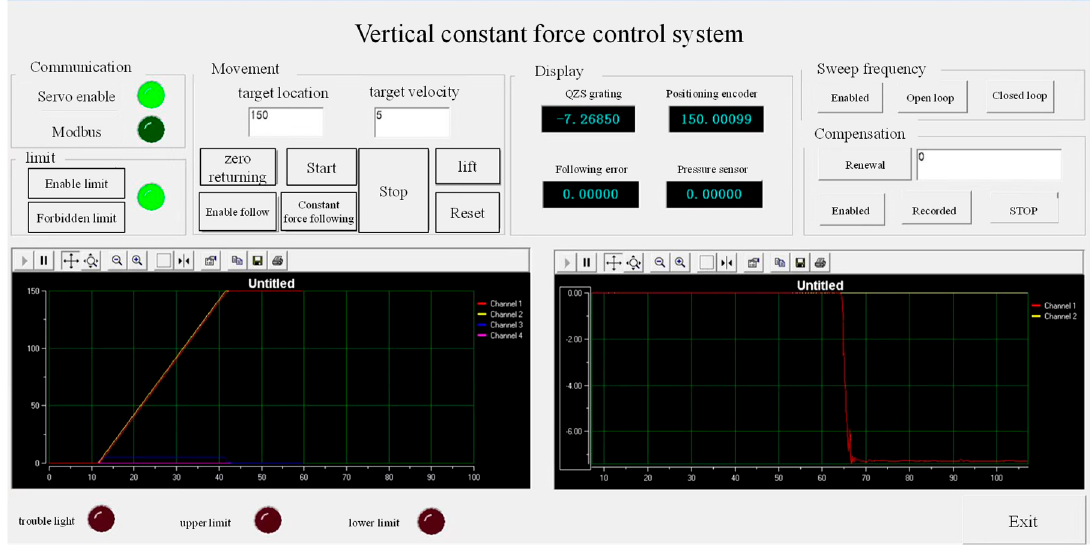
Figure 9. Man–machine interface of M-QZS vertical constant force.